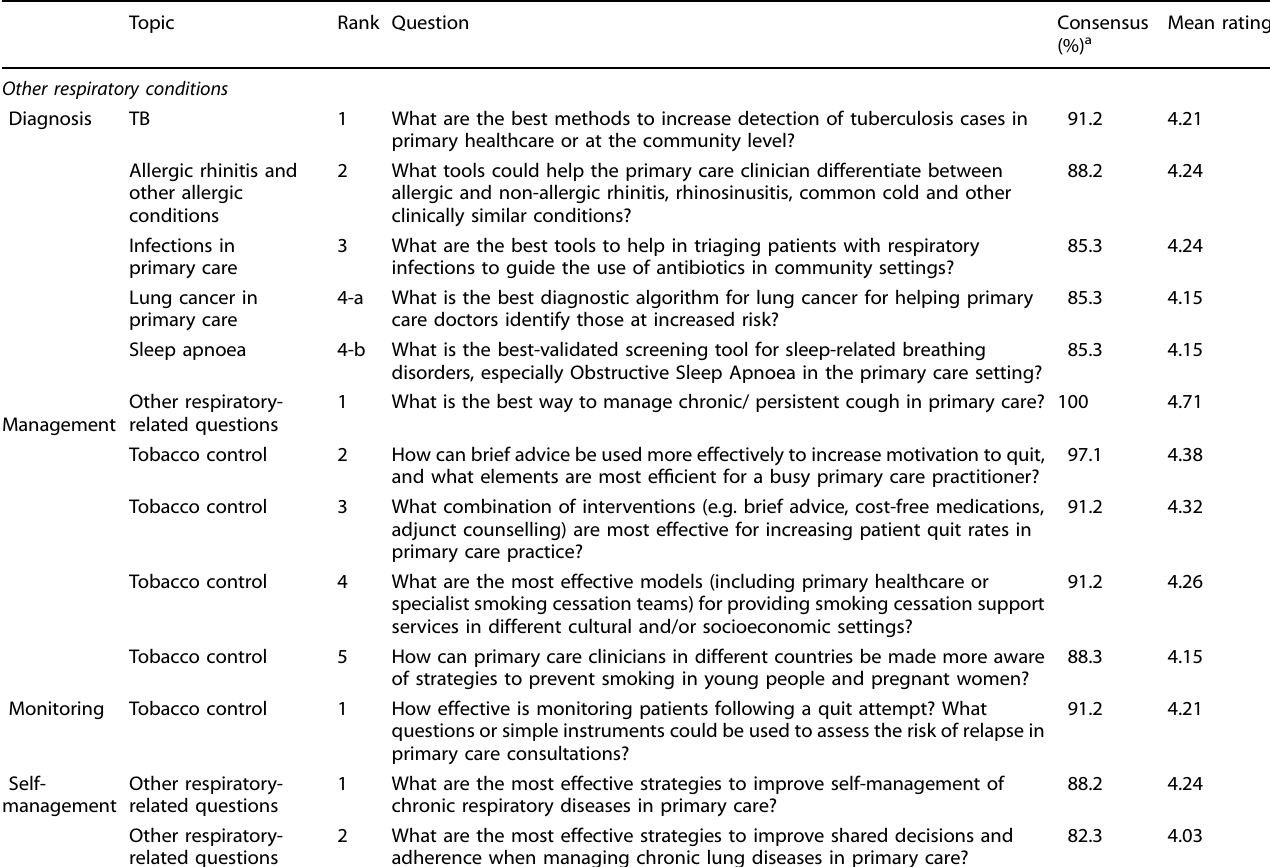
Table 5. Consensus on the research priorities in other respiratory conditions.